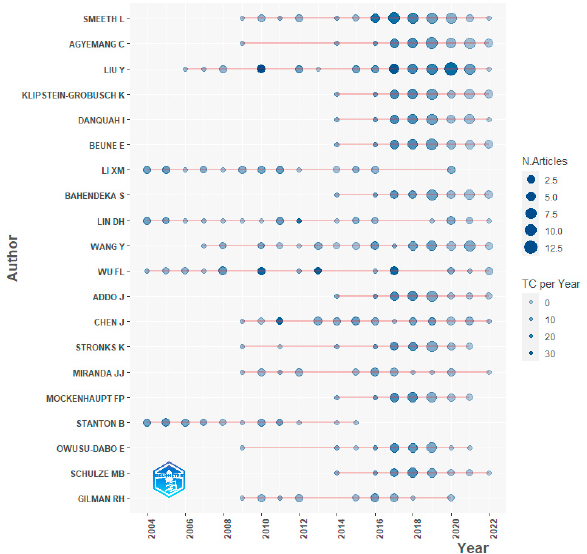
Figure 5. Top 20 authors’ productivity on the topic of rural-to-urban migrants (1 January 2004–3 June 2022).